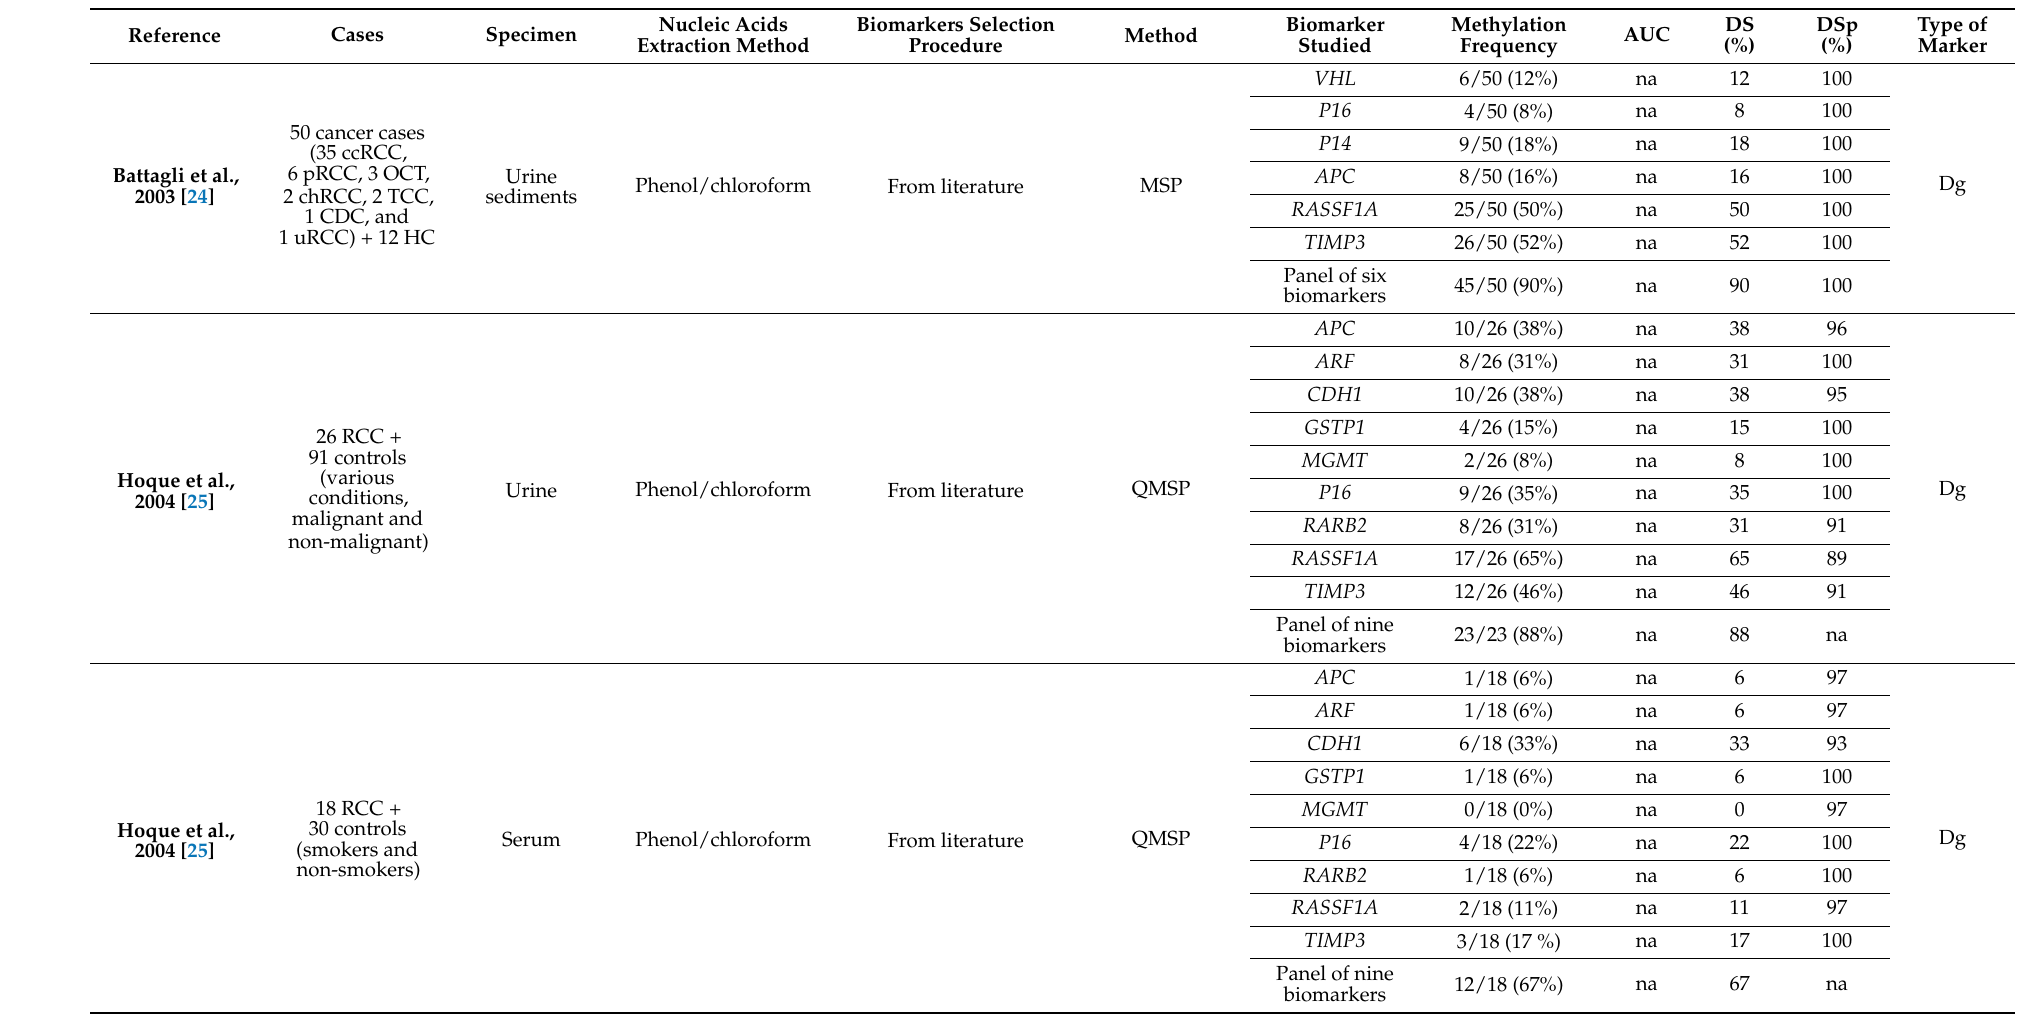
Table 1. Studies concerning DNA methylation in biofluids as a potential biomarker of renal cell